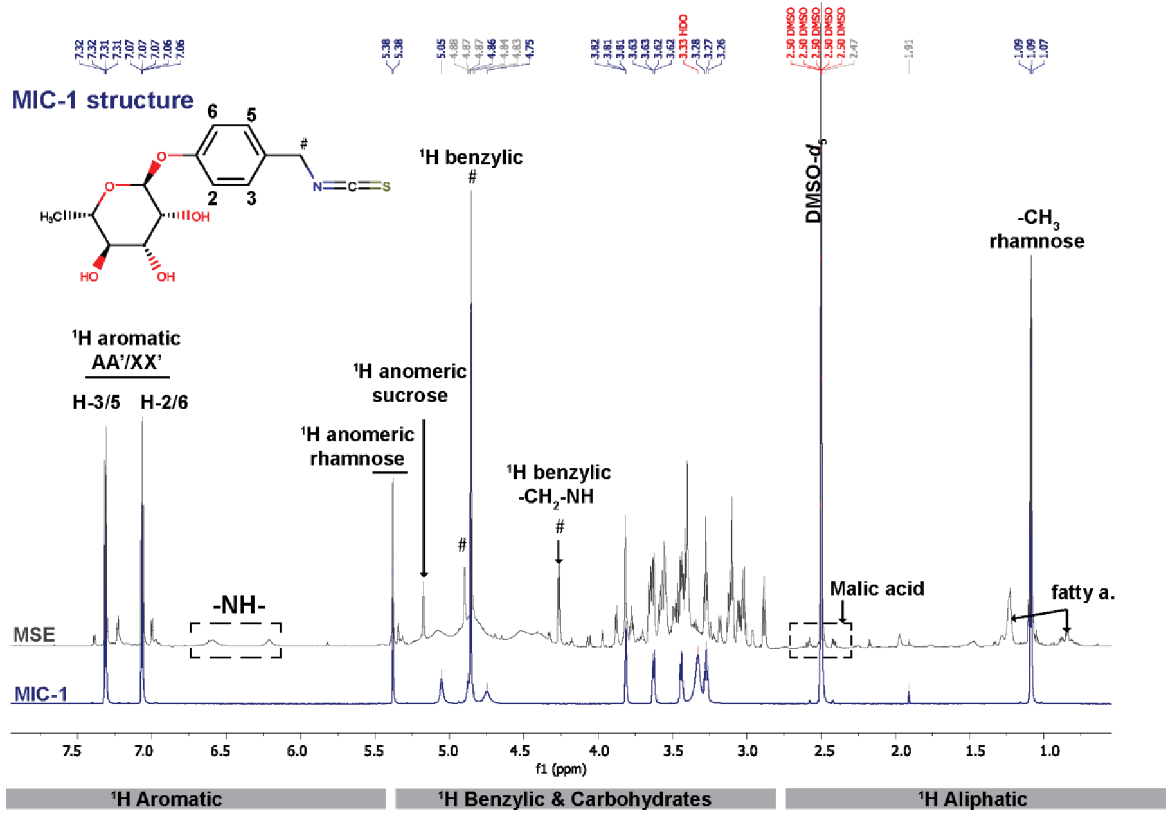
Fig 3. 1 H NMR fingerprinting of optimized MSE (900 MHz, DMSO- d 6 ) compared with the purified MIC-1. Three major regions were identified in the 1 H-NMR fingerprintsof MSE, providingkey structural information of compoundspresent in the crude extract. The results confirmedthan MIC-1 was the most abundantcompound, followedcloselyby congeneric MIC metabolites, sucrose, fatty acids, and malic acid, which were also detected by MS/MS.